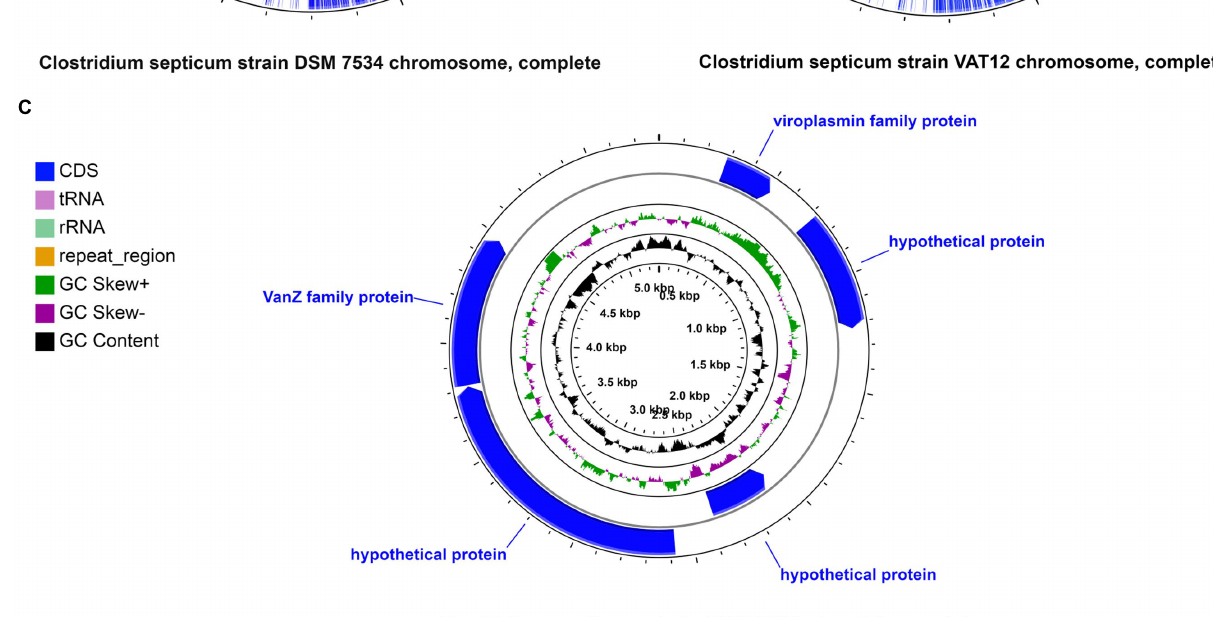
based on the concatenated protein alignment of 400 universal bacterial genes placed the genomes of C. septicum in a separate group with close association to the species C. chauvoei ( Figure 2A ). ANI values between pairs of the five C. septicum genome datasets were more than 99% indicating that all five different genomes met the single species criteria. Pairwise ANI values were ~85% when C. septicum is compared with representative strains of the neighboring species, indicating clear species demarcation ( Figure 2B ). Finally, the C. septicum genomes were highly similar based on the DDH values that ranged from 96.7 to 97.9% for the five genomes in comparison to the C. septicum type strain DSM 7534 T . On the other hand,